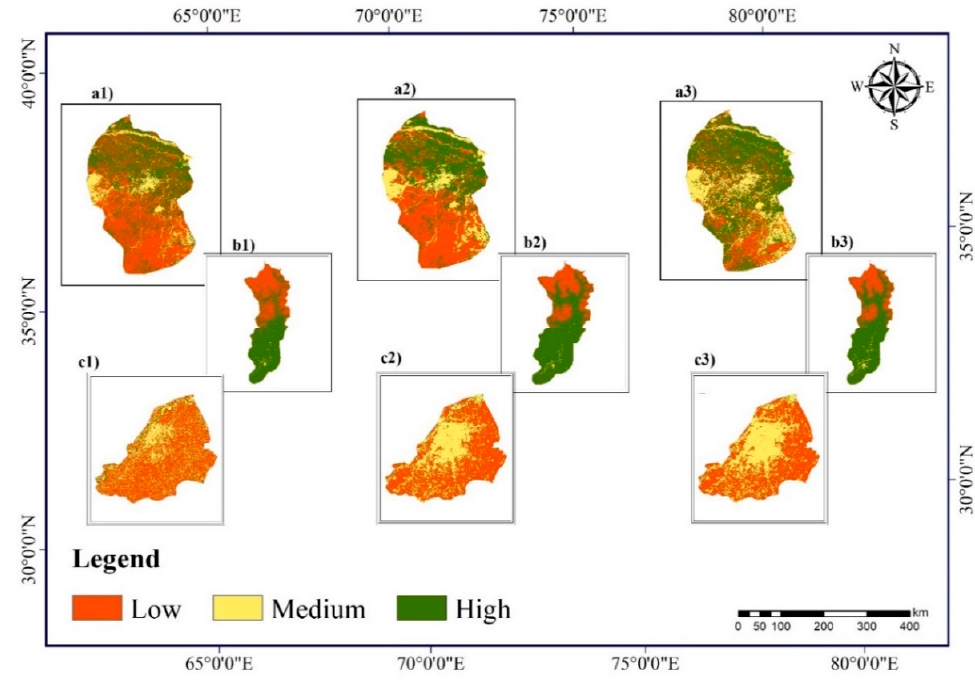
Figure 9. Maps of carbon stock over sites ( a1 ) Peshawar 2000, ( a2 ) Peshawar 2010, ( a3 ) Peshawar